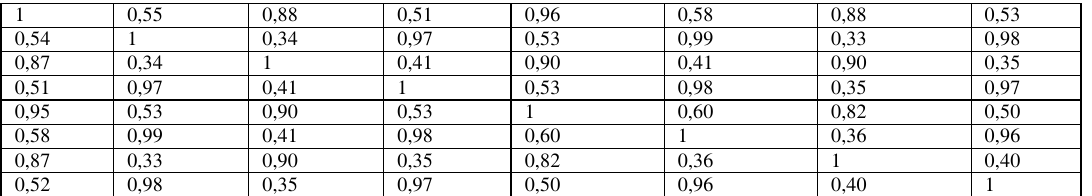
Table 2. Values of the correlation coefficients of autocollimator and microscope (using 4 series of tests)